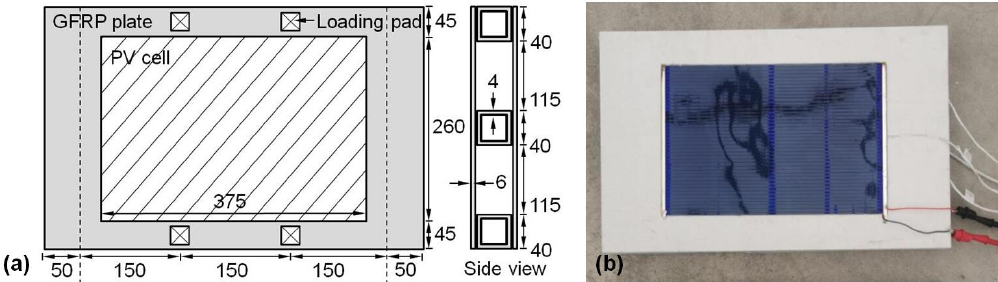
Figure 4. Integration of a-Si PV cell and GFRP sandwich: ( a ) dimension, in mm and ( b ) profile display. During the bending experiments, the specimen was supported at 50 mm from both ends, and artificial sunlight was provided to the PV cell by a halogen lamp. The mechanical PV cells, as shown in Figure 5a. The load was applied at a speed of 0.5 mm/min until the failure of the specimen. The voltage of the PV cell was continuously monitored during loading to show the operational status.